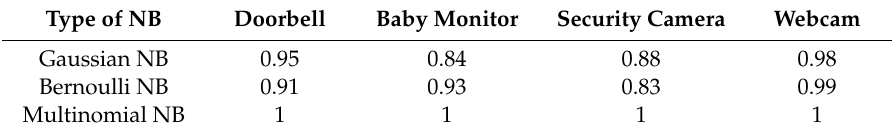
Table 10. Detection F1-score of each naïve Bayes on 4 different devices.